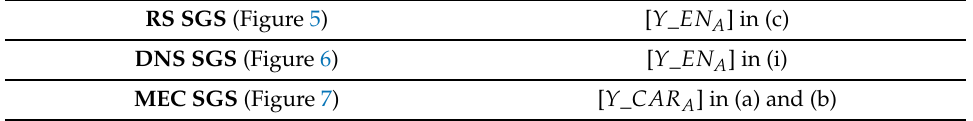
Table 2. Information exposed to